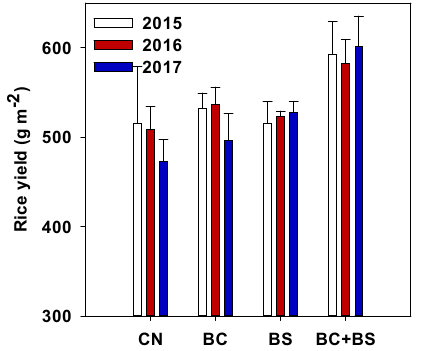
Figure 1. Changes in rice yield from each of the tested areas.